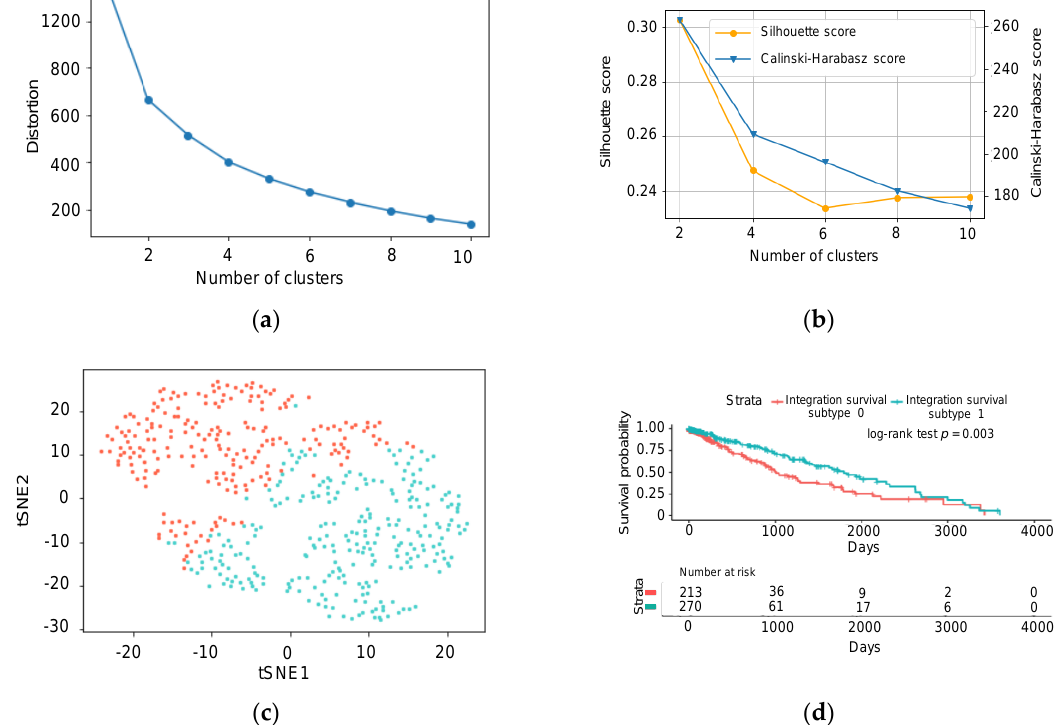
Figure 2 . Prediction of the cluster number and k-means clustering. ( a ) Result of the elbow method. The x -axis shows the number of clusters; the y -axis shows the distortion score. ( b ) Result of the Calinski-Harabasz index and Silhouette Coefficient. The x -axis shows the number of clusters; the y -axis shows the Silhouette score or Calinski-Harabasz score. ( c ) Visualization of the k-means clustering by t-SNE. ( d ) Kaplan-Meier survival curves of integration survival subtypes. Table 2. The summary of data used.